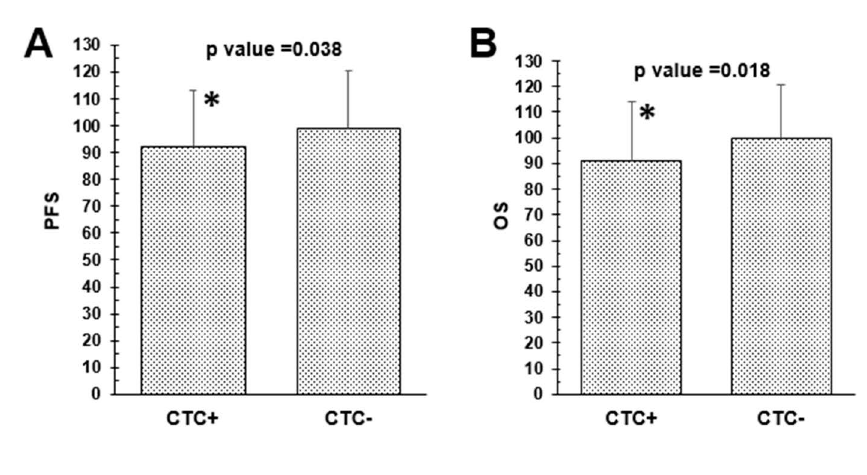
Figure 4. Differences of median with Mann–Whitney U-test of CTCs with outcome. The presence of CTCs was significantly different for shorter progression-free survival ( p = 0.038) and overall survival ( p = 0.018). * p <